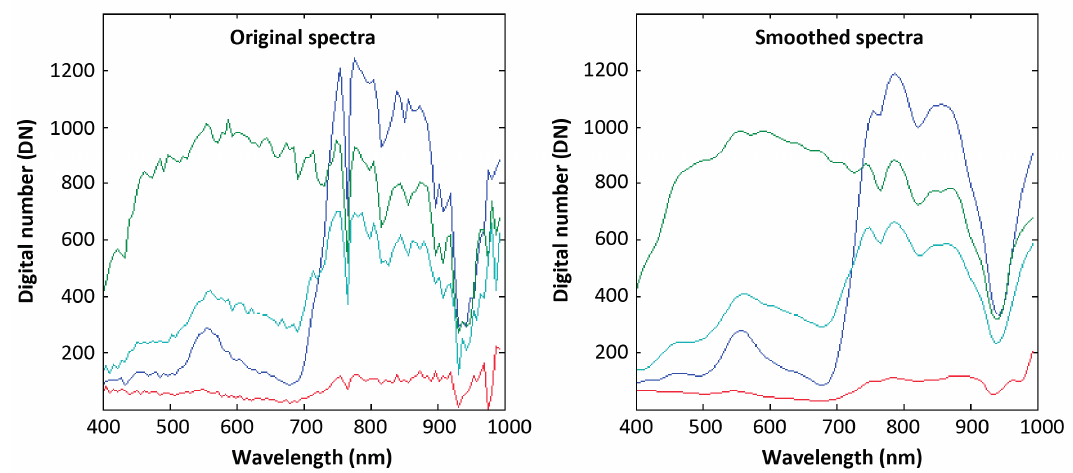
Figure 5. Example spectral profiles before and after smoothing using the Whittaker smoother implemented in ARCTIS: ( left ) original noisy radiance curves; ( right ) smoothed results (with λ = 10). Shown are profiles extracted from the Carnuntum image and belonging to four different cover types: road, gravel, light, and dense vegetation. Each line corresponds to a single pixel. Band numbers (x-axis) are replaced by the corresponding